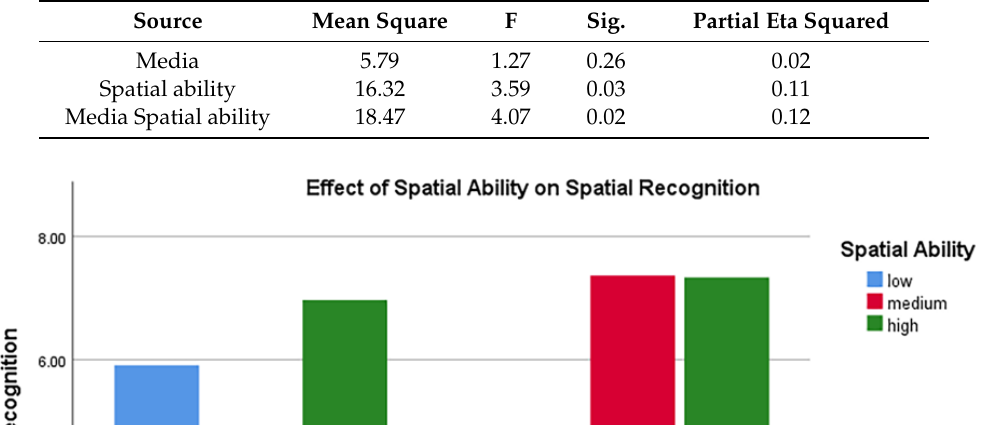
Table 3. Descriptive Statistics for Research Question 1.